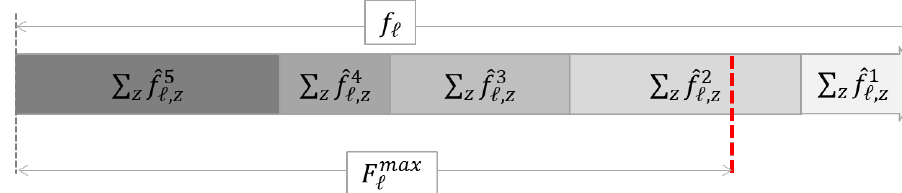
Figure 3. Example of transformation: netted flow components of type 1, and in part type 2, are considered responsible for exceeding the flow limit. In this case, flow type 2 is considered the last one responsible for causing the overload, and transformation algorithm (defined in Table A1) terminates while reaching the following set of ρ -coefficients: ρ 1 = 1; ρ 2 = 0.3; ρ 3 = ρ 4 = ρ 5 =